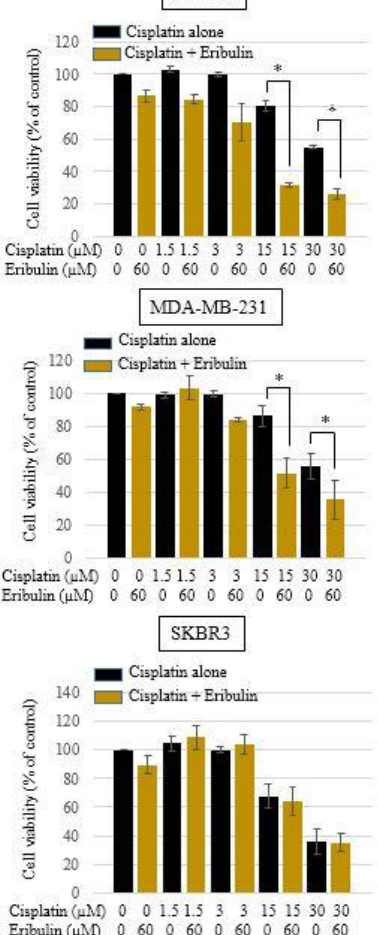
Figure 3. Combined effect of cisplatin and eribulin on HCC38, MDA-MB-231, and SKBR3 breast cancer cells. Cells were treated with cisplatin (1.5, 3, 15, and 30 µM) or a combination of cisplatin and eribulin (60 µM). After 24 h of exposure, cell viability was measured using a Cell Counting Kit-8 assay. Each assay was performed in triplicate. Data are presented as the mean ± standard deviation; * p < 0.05 vs. cisplatin-only treatment.